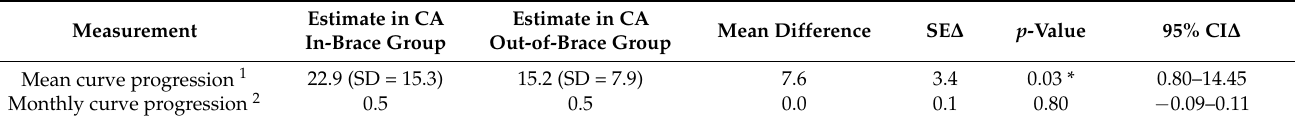
Figure 1. Cobb angle progression over time of the in-brace group and out-of-brace group. Cobb angle measurements on follow-up radiographs were clustered in time intervals of 6 months ± 3 months. The formulas for the estimated monthly Cobb angle progression in the in-brace (2.8 + 0.5*x) and out-of-brace group ( − 3.8 + 0.5*x) were formed using the mixed-effect model with adjustment for baseline Cobb angle score and initial in-brace correction and time included as a linear term. Table 3. Curve progression over